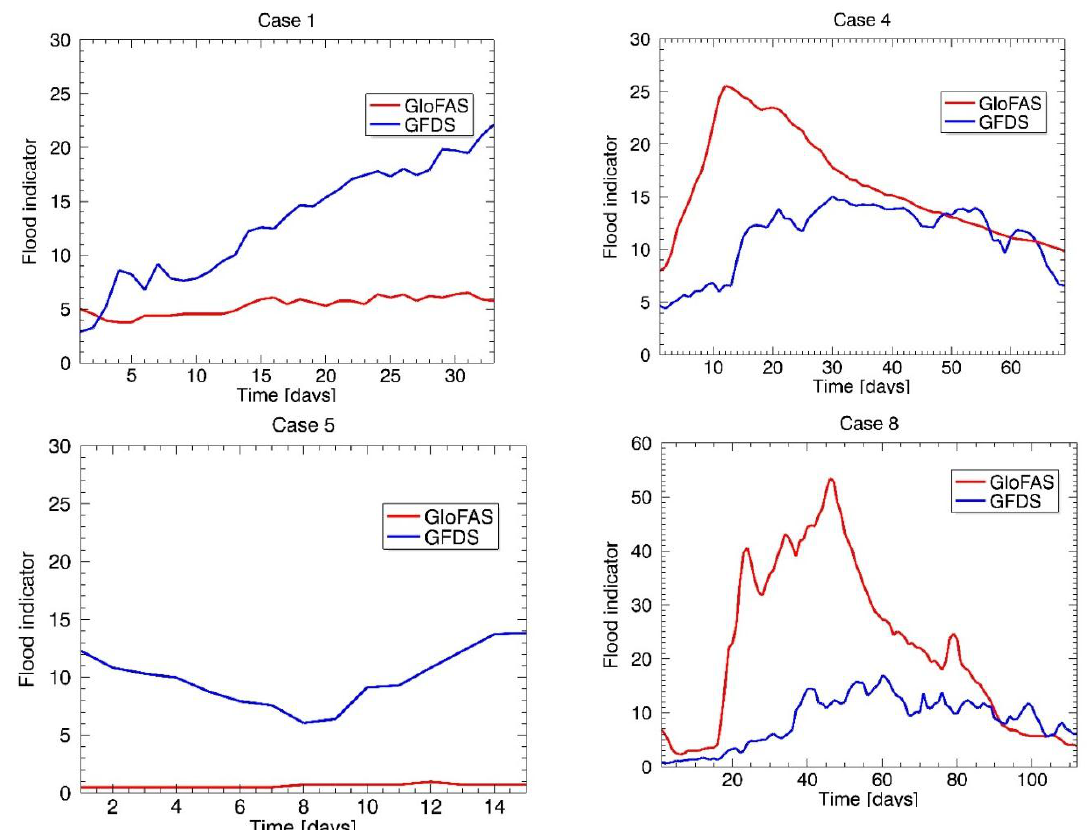
Figure 4. Time series comparison of the flood extent (% of grids indicating flood) for the GFDS detection (Magnitude > 4) and GloFAS 1-day lead forecast (median > 20-year